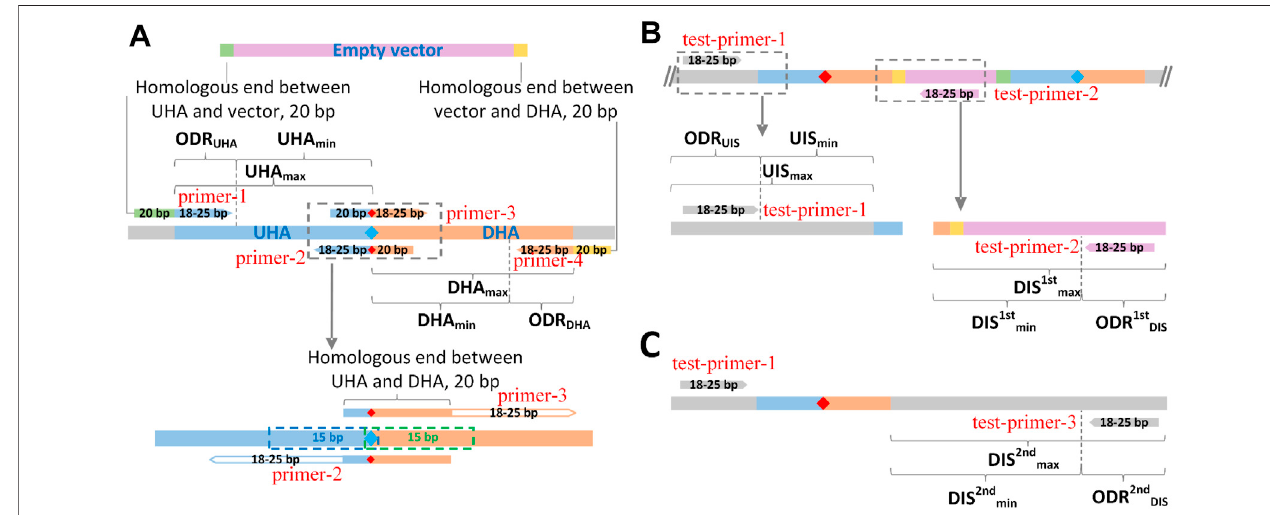
FIGURE 3 | Schematic diagram of the design principle of GEDpm-cg. Parameter settings for the design of primers and homologous arms for the vector DNA assembly (A) , the 1 st -round of single crossover and isolation (B) and the 2 nd -round of single crossover and isolation (C) . UHA, upstream homologous arm; DHA, downstream homologous arm; green band, homologous end between UHA and vector; yellow band, homologous end between DHA and vector, blue diamond, base before point mutation; red diamond, base after point mutation. UHA min-max , length range of upstream homologous arm; ODR UHA , optional design region of upstream homologous arm; DHA min-max , length range of downstream homologous arm; ODR DHA , optional design region of downstream homologous arm; UIS min-max , length range of upstream internal sequence (sequence from 5 ′ -end of test-primer-1 (forward primer for veri fi cation of the 2 nd round of crossover) to the 5 ′ -end of the upstream homologous arm); ODR UIS , optional design region of forward primer (test-primer-1) for veri fi cation of the 2 nd round of crossover; DIS 1st min-max , length range of downstream internal sequence for veri fi cation of the fi rst single crossover (sequence from the 3 ′ -end of the downstream homologous arm to the 5 ′ -end of test-primer-2 (reverse primer for veri fi cation of the 1 st single crossover)); ODR 1st DIS , optional design region of reverse primer (test-primer-2) for the veri fi cation of the fi rst single crossover; DIS 2nd min-max , length range of downstream internal sequence for the veri fi cation of the second single crossover (sequence from the 3 ′ -end of the downstream homologous arm to the 5 ′ -end of test-primer-2 (reverse primer for the veri fi cation of the 1 st single crossover)); ODR 2nd DIS , optional design region of the reverse primer (test-primer-3) for veri fi cation of the second single